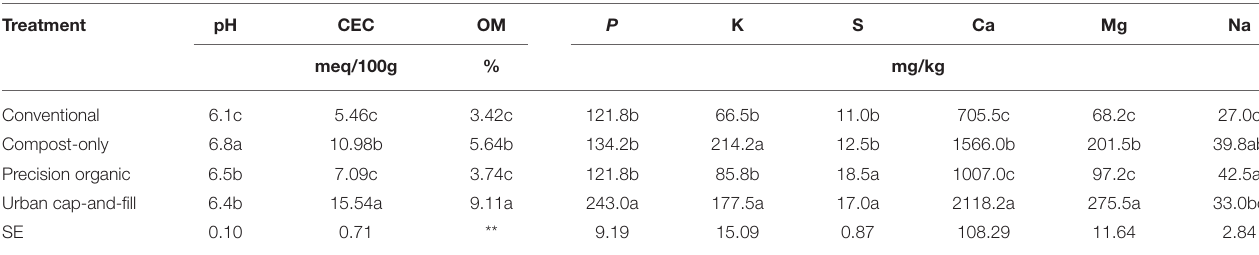
TABLE 7 | Chemical properties of soils after three growing seasons (October 2019).